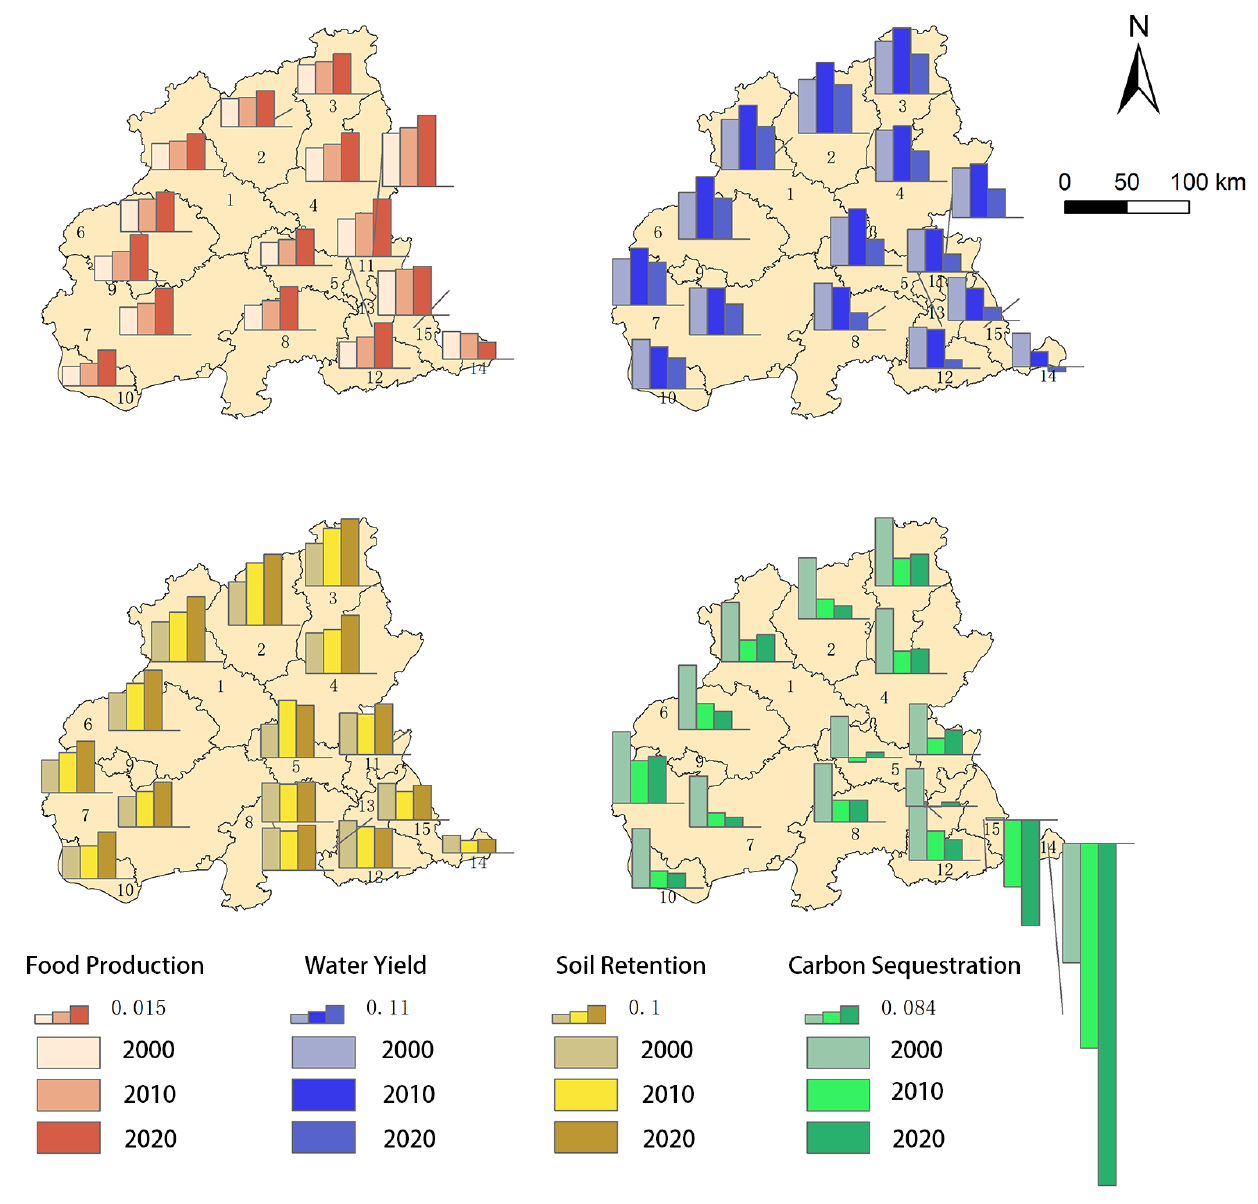
Figure 5. Variations in the ESs supply-demand ratio in different subproject areas.